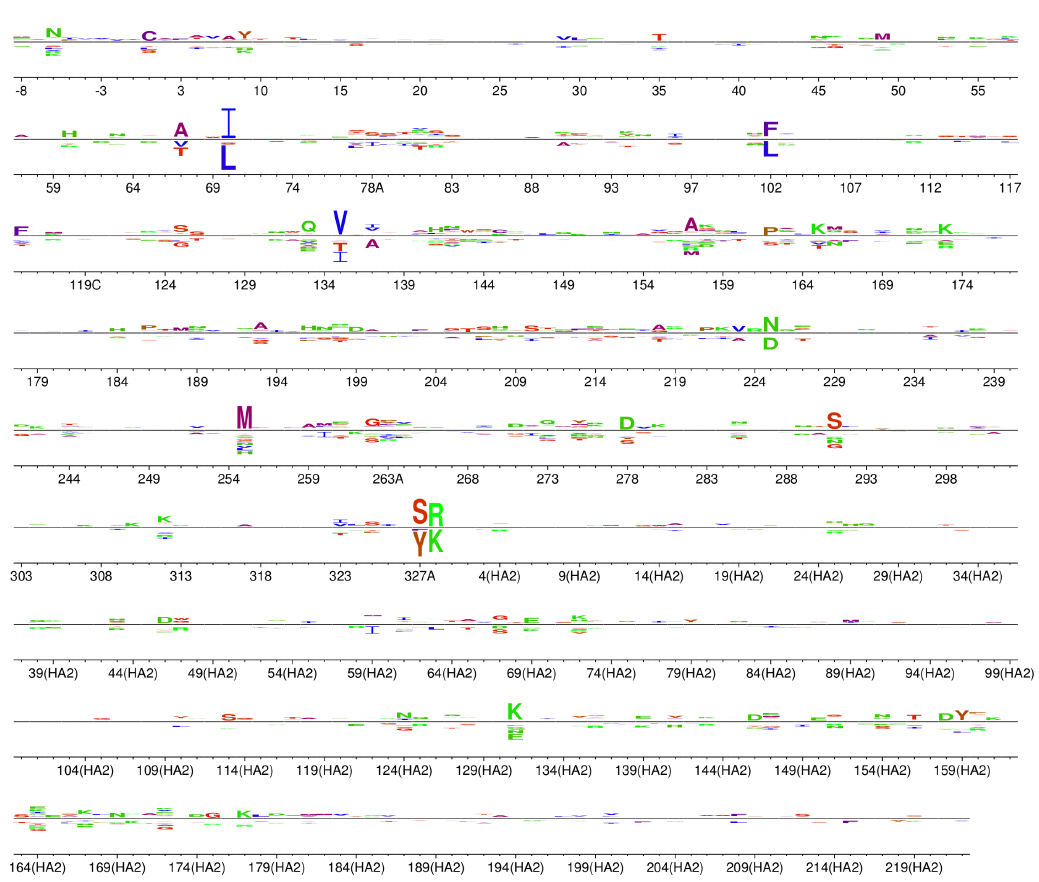
Figure 4. Differential selection between our selection in the lab and HA’s evolution in nature. The approach in [24] was used to determine the magnitude of differential selection between the deep mutational scanning and the natural evolution of human seasonal H1N1 and classical swine H1N1 HAs. At each site, the height of a letter above or below the center line indicates that differential selection for or against that amino acid in nature as compared to our experiments. At most sites, the differential selection is very small, showing that the experimental measurements are mostly concordant with natural selection on HA. However, a few sites are under very different selection in nature as compared to our experiments. The sequence is numbered using the H3 numbering scheme. Amino acids are colored by hydrophobicity as in Figure 3. Conversion between WSN sequential numbering and H3 numbering is provided in File